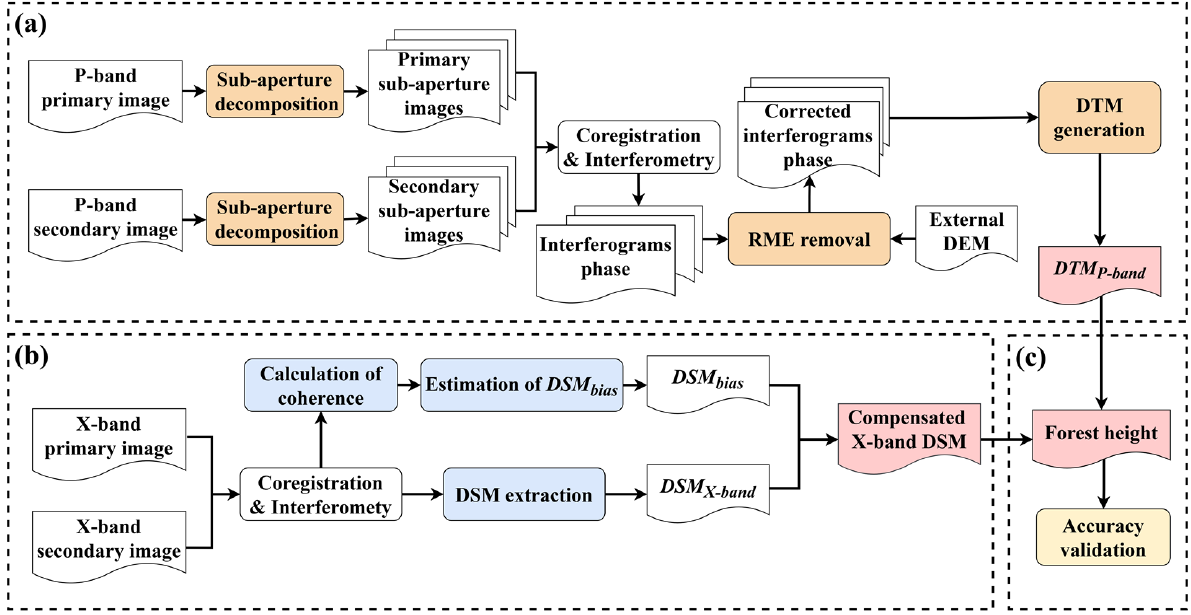
Figure 2. The flowchart of the proposed method: ( a ) DTM extraction based on P-band InSAR; ( b ) DSM extraction and compensation based on X-band InSAR; ( c ) Accuracy validation.